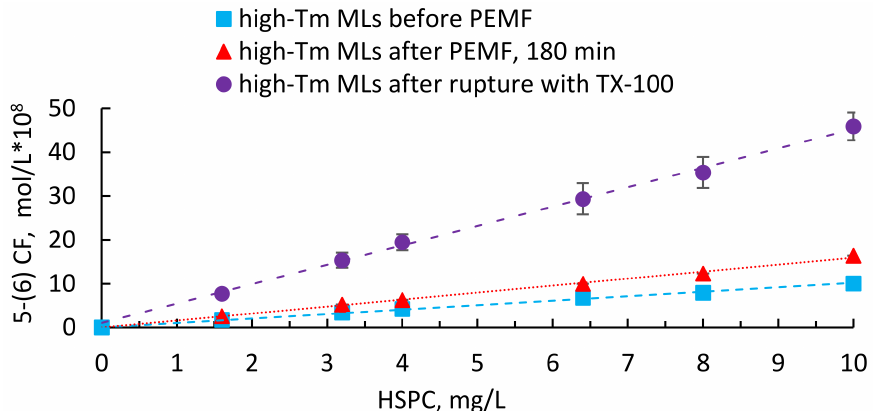
Figure 4. Release data of 5-(6) CF from high-Tm MLs before and after PEMF exposure. The results are reported as molar concentration of marker per different lipid concentrations and compared with the total amount of fluorescent dye released after complete destruction of high-Tm MLs with Triton X-100. (cid:104) (cid:105) + 4.18 ( R 2 = 1.00), was used to establish a The calibration curve, F A.U = 1.47 × 10 9 5 − ( 6 ) CF mol L relationship between 5-(6) CF fluorescent intensity and dye concentration (as reported in